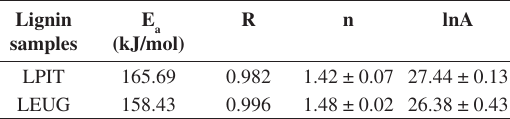
Table 2. Kinetic parameters obtained for the lignins studied . Lignin